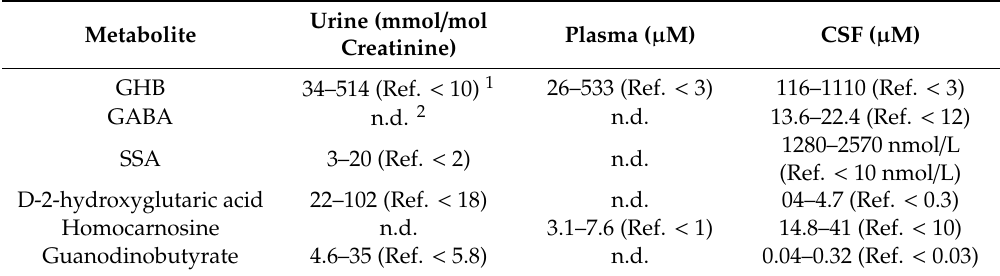
Table 1. Accumulation of potentially harmful GABA metabolites in the body fluids of SSADH-D patients. Modified from